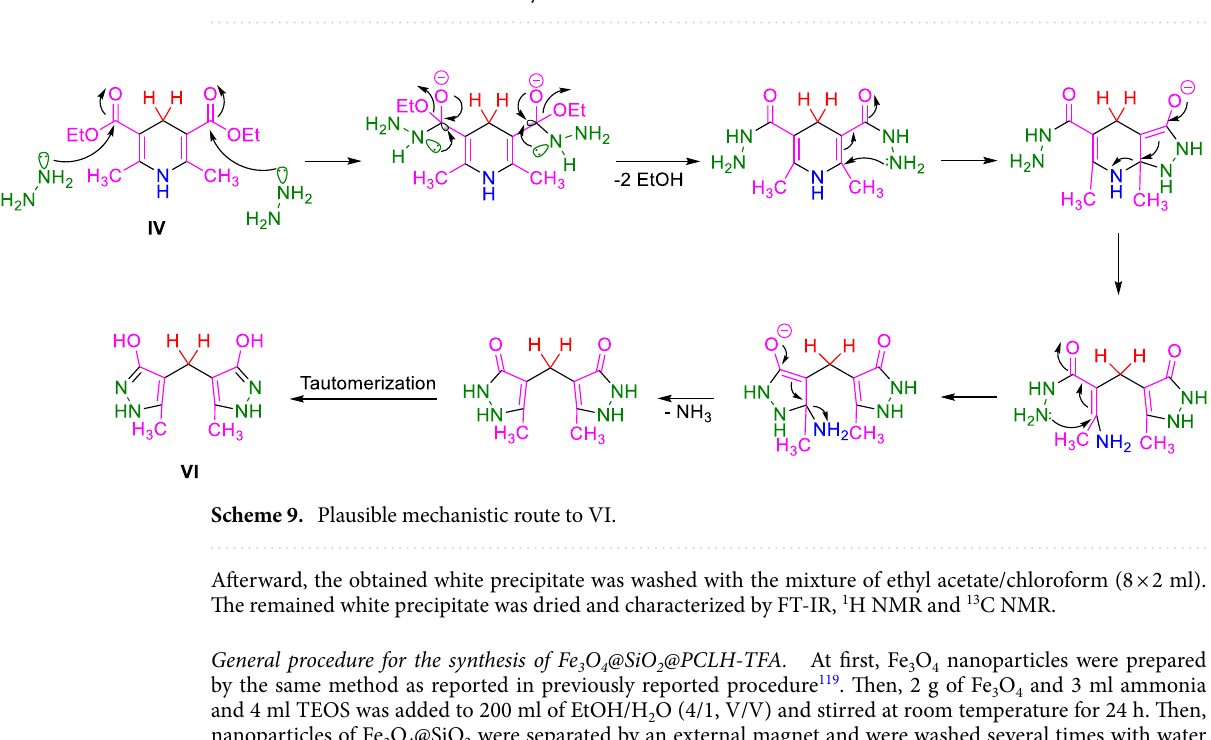
Figure 10. The ORTEP diagram of VI . Thermal ellipsoids are at 30% probability level. Disordered DMSO molecule has been omitted for clarity.